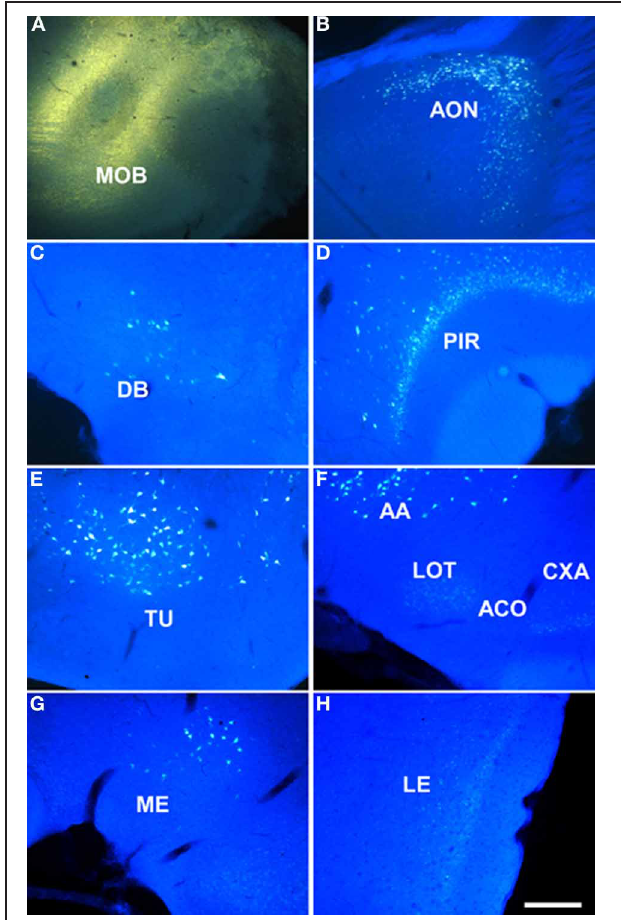
FIGURE 1 | Sagittal (A,B) and coronal sections (C–H) from rostral to caudal levels of the telencephalic hemisphere showing the resulting labeling (B–H) after a FluoroGold injection in the rat main olfactory bulb (A). Abbreviations: AA, anterior amygdala; ACO, anterior cortical amygdala; AON, anterior olfactory nucleus; CXA, cortex-amygdala transition zone; DB, nucleus of the diagonal band; LE, lateral entorhinal cortex; LOT, nucleus of the lateral olfactory tract; ME, medial amygdala; MOB, main olfactory bulb; PIR, piriform cortex; PLCO, posterolateral cortical amygdala; TU, olfactory tubercle. Scale bar for A : 1000 μ m, B–H : 400 μ m.